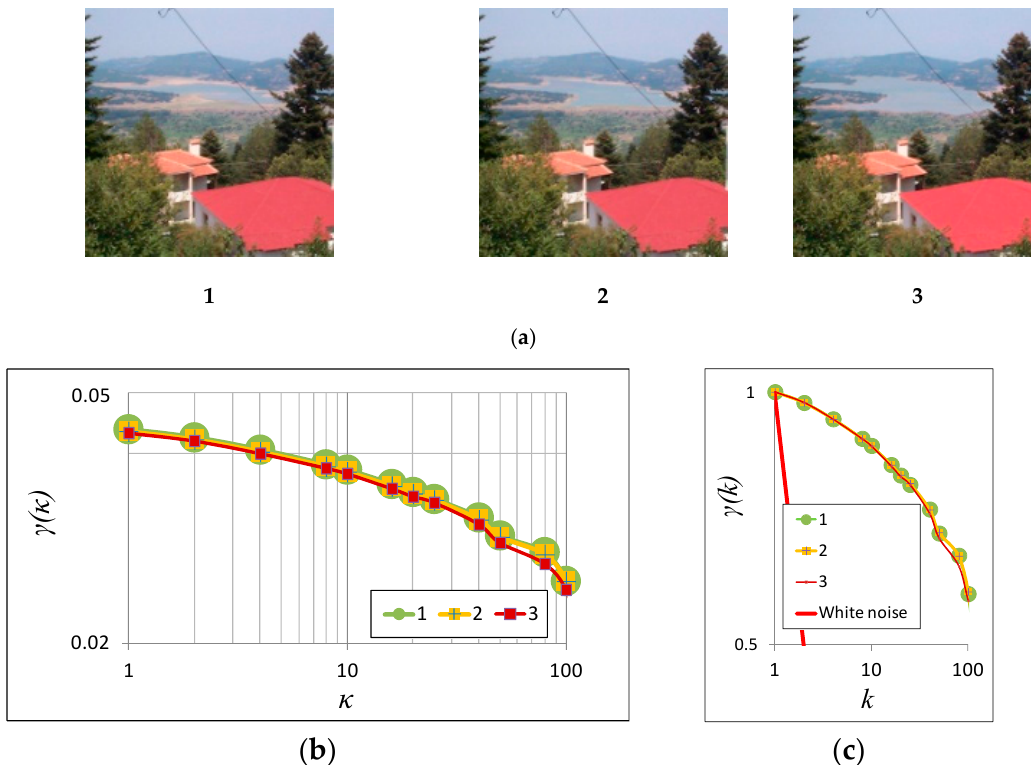
Figure 7 . ( a1 – a3 ) Transformation of landscape of Plastiras caused by the fluctuation of the lake water elevation in the area of subnormal dead zone; ( b ) climacograms and ( c ) standardized climacograms of images ( a1 – a3 ) .